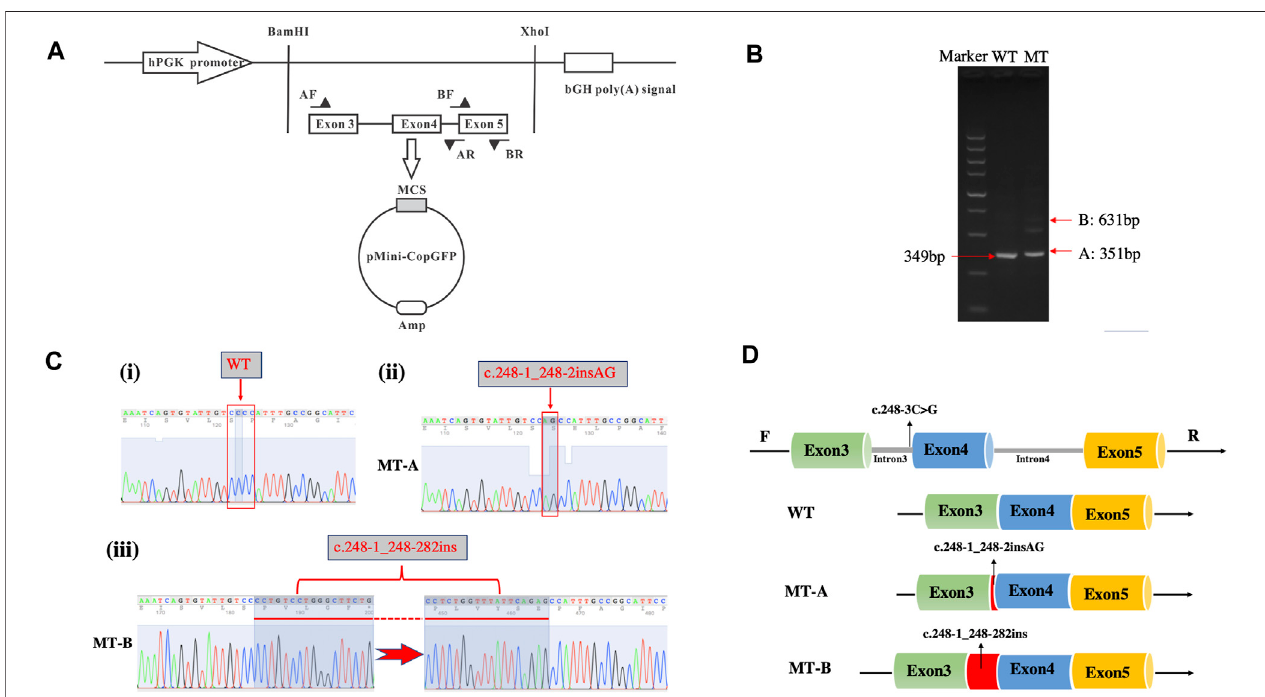
FIGURE 3 | Minigene assay for FBN1 c.248-3C > G variant and schematic diagram of the splicing pattern. (A) Minigene trapping vetor construct; (B) Gel electrophoresis of RT-PCR revealed a single band for wild-type and two bands for mutant-type; (C) minigene product sequencing demonstrated that the wild-type minigeneformed normal mRNA(i),but thec.248-3C > Gsubstitution ofFBN1caused asplicingabnormality, whichabrogate theintron 3canonicalsplice site andleadto activatingtwo cryptic sites in exon 4, resulting in a 2 bp insertion (ii) and 282 bp insertion (iii); (D) the schematic diagram ofsplicingpatternof WT, MT-A and